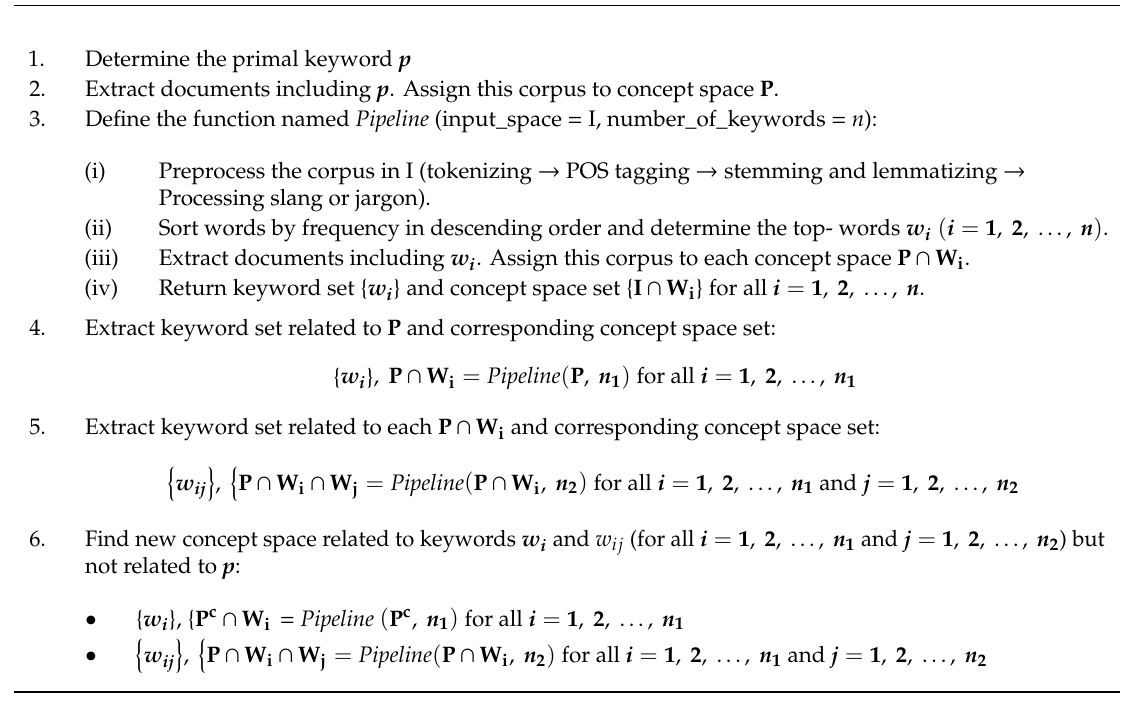
Table 3. Hierarchical Search of Concept Spaces (HSCS) algorithm. Algorithm 1: Hierarchical Search of Concept Spaces